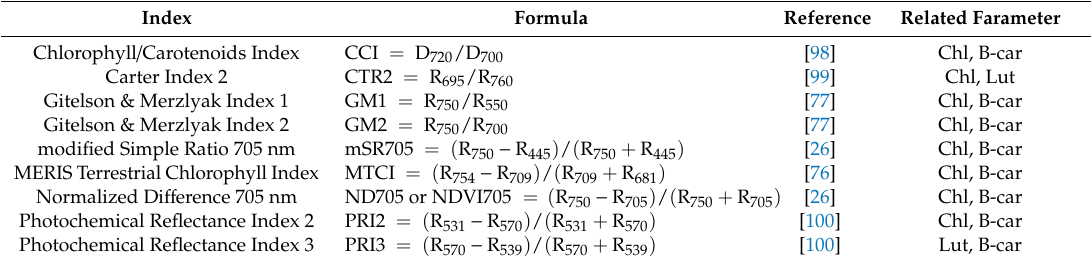
Table A1. Vegetation indices used in the method of detection. For each index, the related biochemical parameters are specified. These parameters have been identified in a previous study carried out on